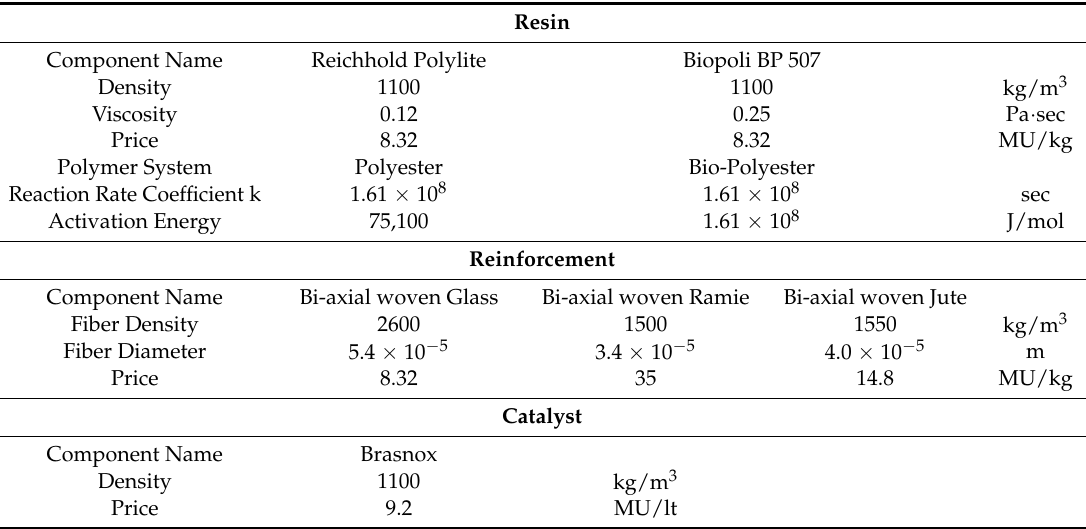
Table 3. Materials features and